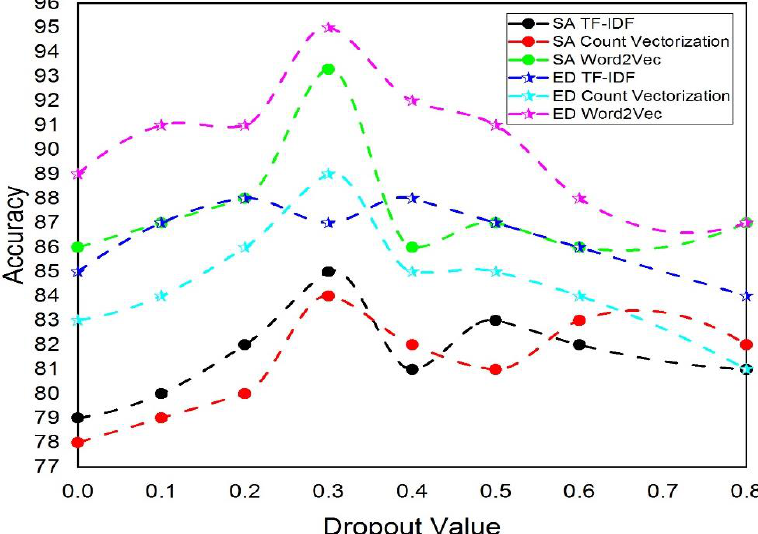
Figure 6. Comparison of Results with Dropout Values for Emotion Detection and Sentiment Anal- ysis.